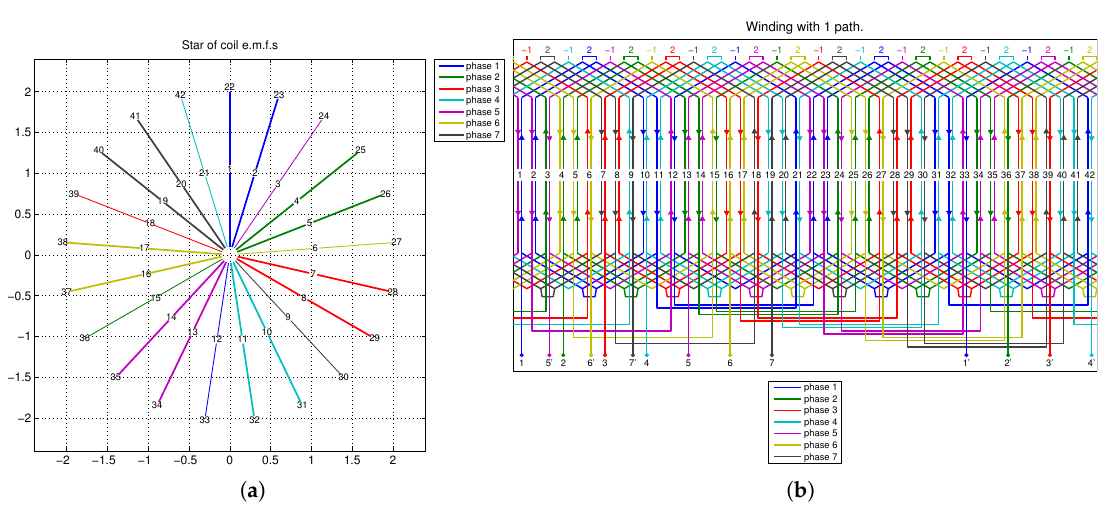
Figure 13. Double layer seven-phase symmetrical winding with N = 42, p = 2, m = 7, y c = 9 and q = 1 + 1 / 2 . ( a ) Star of slots and ( b ) winding scheme.